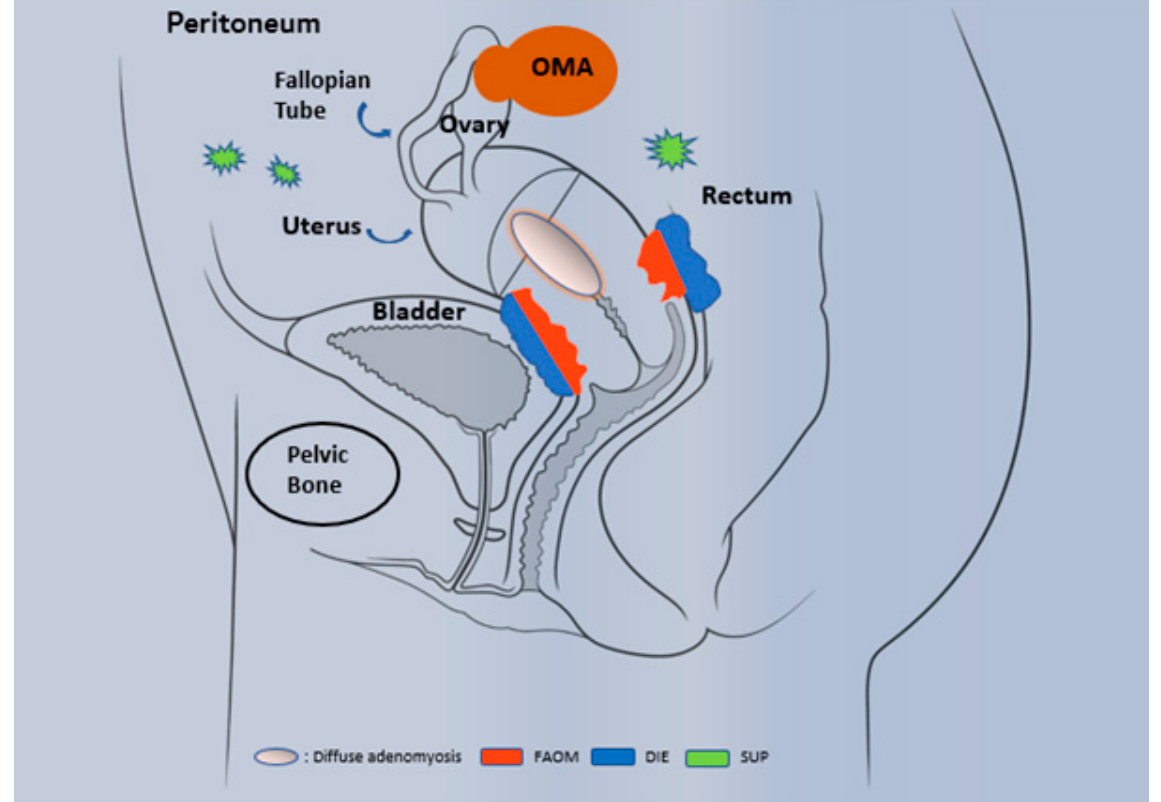
Figure 1. Phenotypic description of endometriosis and adenomyosis. Three well-recognized phenotypes occur in endometriosis: superficial peritoneal lesion (SUP), ovarian endometriomas (OMA) and deeply infiltrating endometriosis (DIE). In specific cases, the invasion of endometrial tissue towards the uterus leads to the establishment of adenomyosis, a specific entity that differ from endometriosis and present different forms: diffuse adenomyosis and focal adenomyosis of the outer myometrium (FAOM).